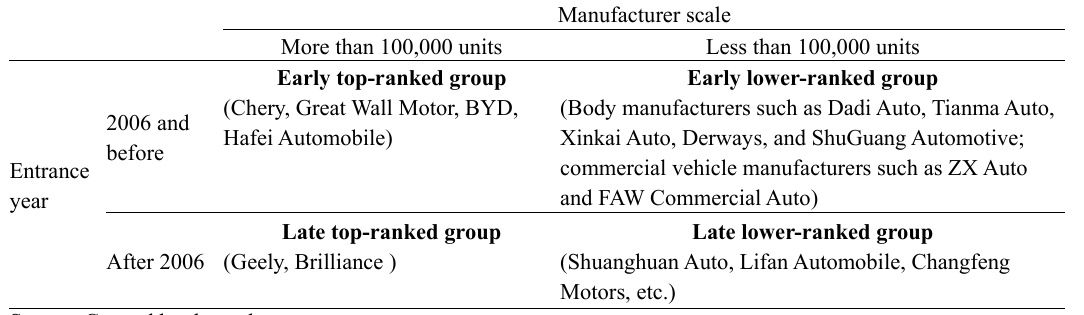
Table 5. Group divisions among independent manufacturers in the Russian